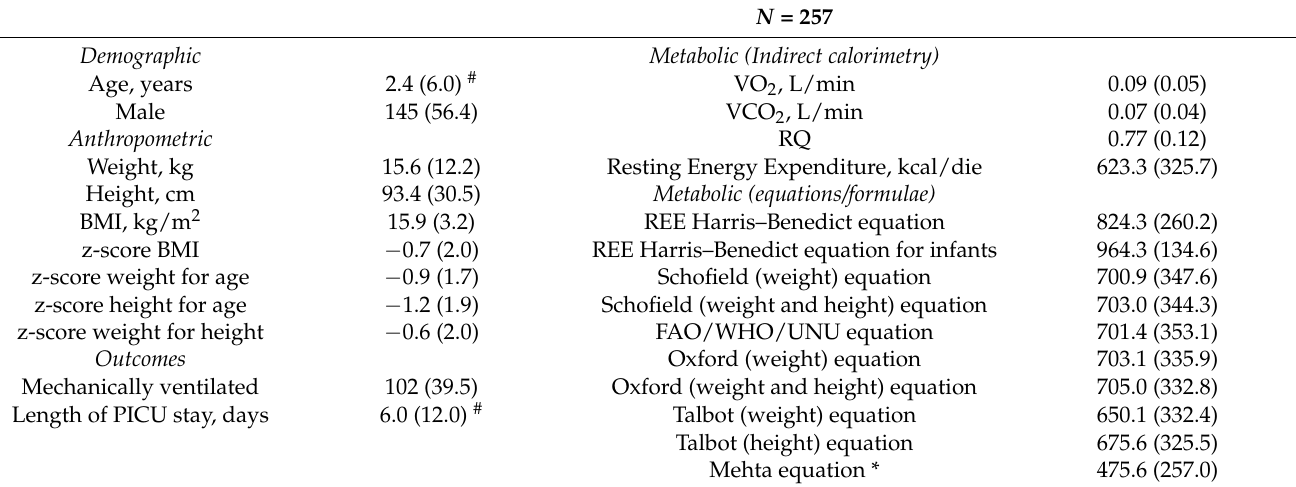
Table 1. Anthropometric and metabolic measurements of the study